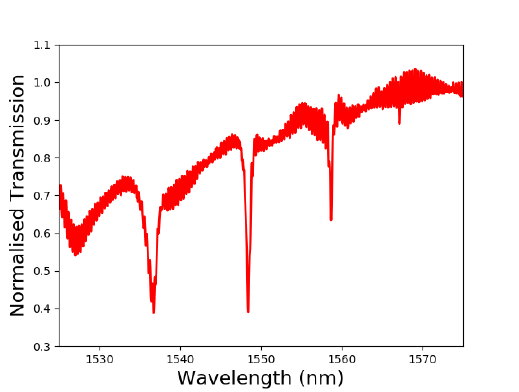
Figure 4. Measured optical transmission spectrum of the PhC cavity with lattice spacing 386nm. The PhC cavity Free Spectral Range (FSR) is greater than 11.8nm.